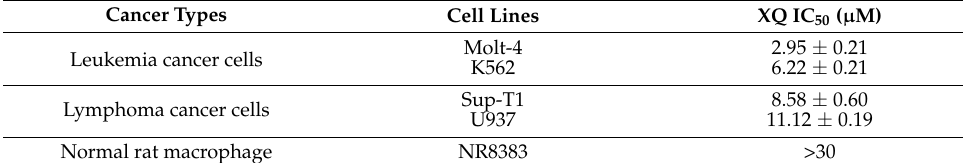
Table 1. Cytotoxic effect of XQ against cancer cell lines and non-cancer cell lines.